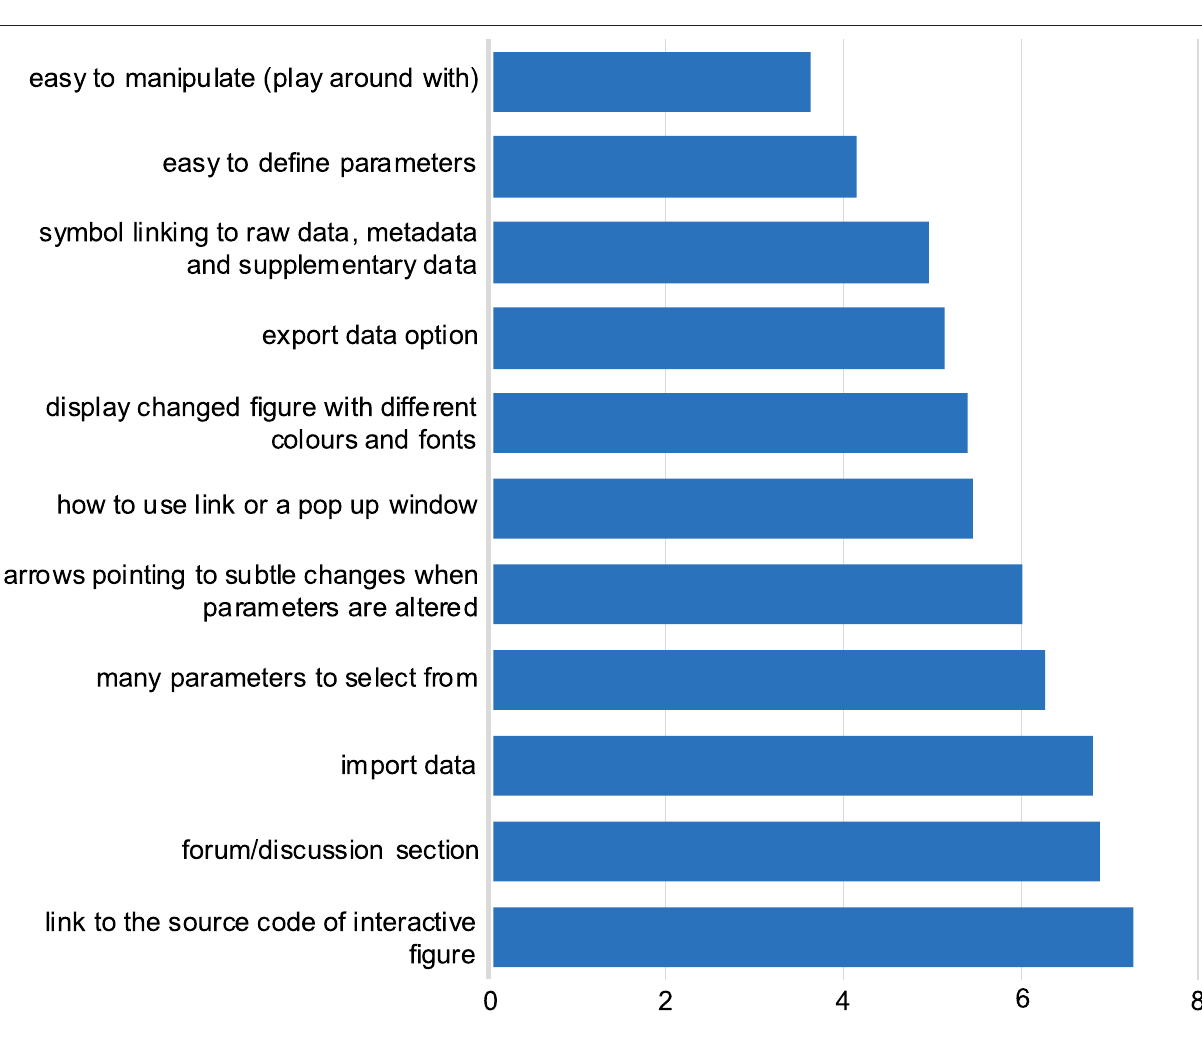
FIGURE 3 | Preferred features for the interactive fi gure. Responses toquestion 9: Respondents were asked to rank in order of preference the above features, with one most preferred feature, to 11 the least preferred feature. The average score for each feature was calculated in order of preference as selected by the respondents from both NBI and eLIFE surveys. The lower the average score value ( x -axis), the more preferred the feature ( y